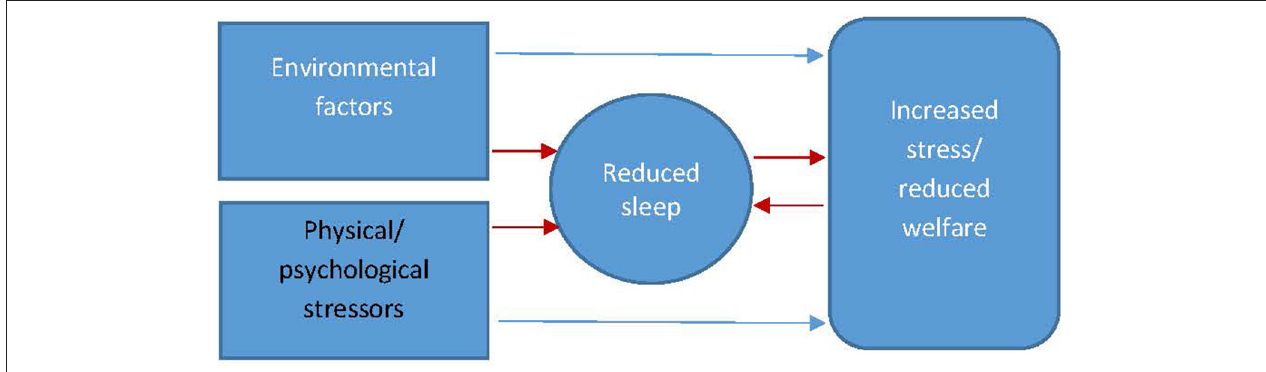
FIGURE 4 | The interrelationship between factors of wellbeing affecting sleep and sleep affecting wellbeing (red arrows indicate the pathways to reduced sleep and the interplay between increased stress/reduced welfare and reduced